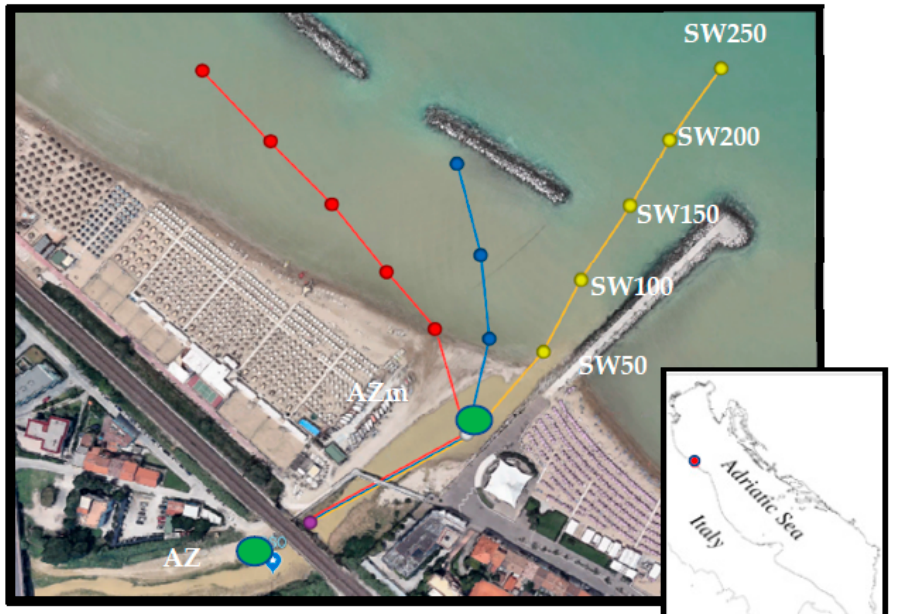
Figure 2. Study site and sampling strategy. Two sampling stations were positioned along the Arzilla River (green dots), AZ (where is located the automatic water sampling for microbiological and chemical analyses) and at Arzilla mouth (AZm). On the sea, sampling stations were distributed along three transects at increasing distances from the shore (orange dots). Transect 1 near the coastline (red line): Transect 2 in the middle (blue line); Transect 3 in front of the river mouth (yellow line).